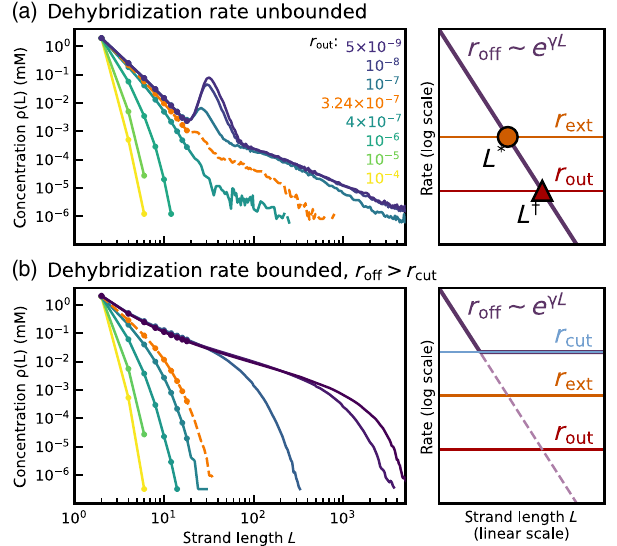
FIG. 3. Stationary length distributions (left) and competition of timescales (right) for the standard model (a) and its bounded variant (b) for different values of the outflux rate r bounded model, dehybridization cannot become smaller than r 0 . 05 . Dehybridization is thus faster than ligation cut ¼ 2 . 5 × 10 − 3 ) for all lengths. In both models, the length ( r lig ¼ distributions develop long tails when decreasing the outflux rate r . The orange (dashed) curves correspond to a system where the out outflux rate takes the crossover value r cf. Eq. (6). For outflux rates below the transition value, the unbounded model exhibits a nonmonotonic length distribution with a local minimum and maximum at L